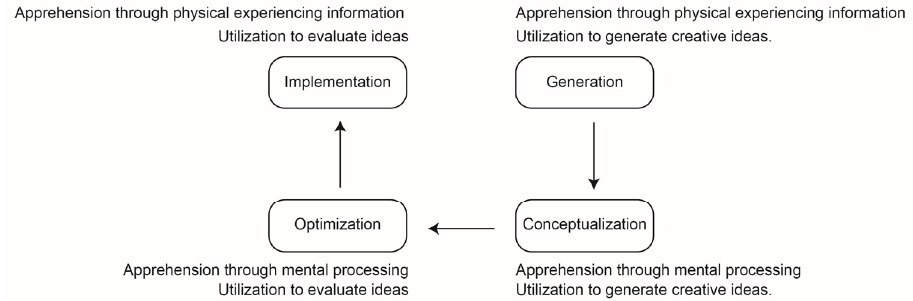
Figure 2. Combination of four different methods of gaining and using.